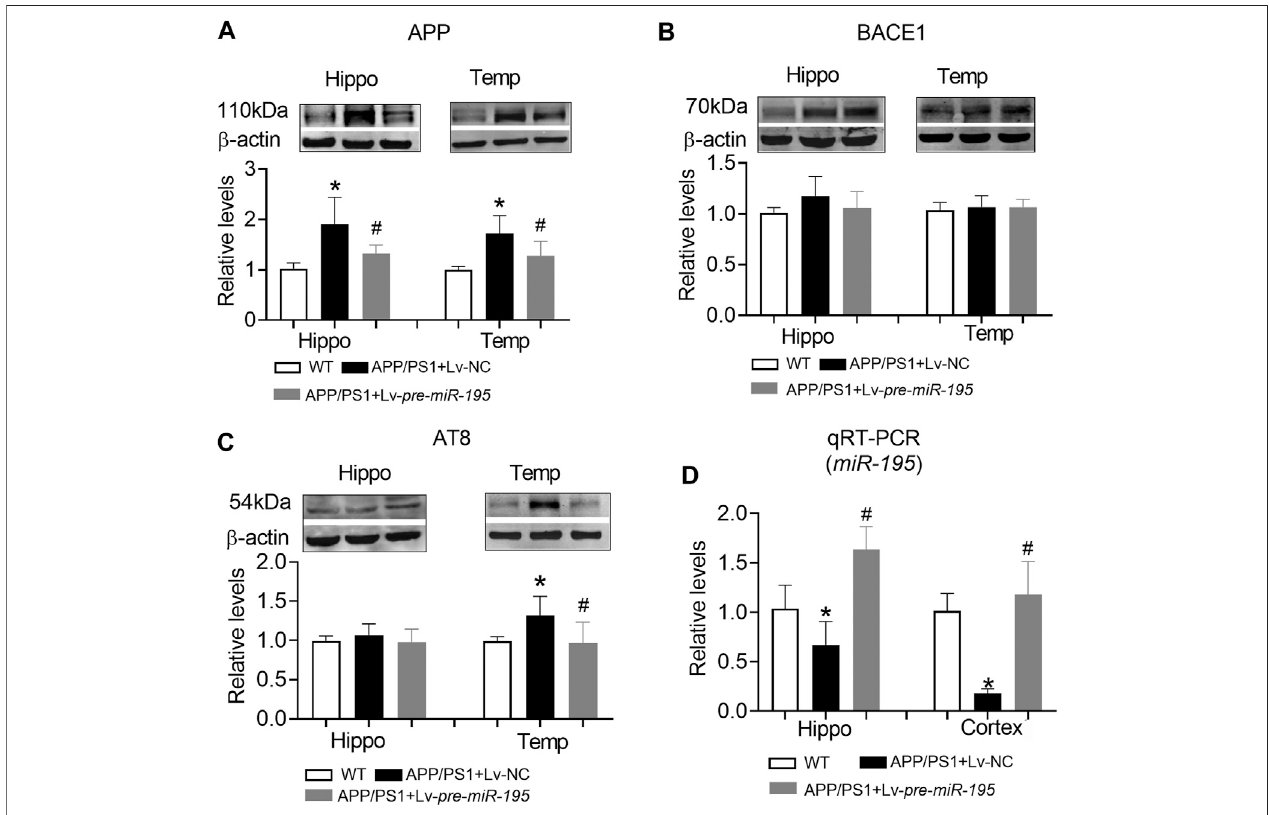
FIGURE 7 | The effect of miR-195 on the expression of APP, BACE-1, AT8 protein in the hippocampi of APP/PS1 mice after Lv-pre -miR-195 injection for 3M (A) MiR-195 down-regulated the expression of APP protein in the hippocampus and temporal lobe of APP/PS1 mice. * p < 0.05 vs. WT. # p < 0.05 vs. Lv-NC (B) There was no signi fi cant change in BACE-1 protein in hippocampus and temporal lobe of 7M-old APP/PS1 mice (C) MiR-195 reverses the high expression of AT8 in the temporal lobe of 7M-old APP/PS1 mice, but not in the hippocampus. * p < 0.05 vs. WT (D) MiR-195 levels in the hippocampus and cortex of APP/PS1 mice after brain injection of Lv-pre -miR-195 for 3M. * p < 0.05 vs. WT. # p < 0.05 vs. Lv-NC. n (cid:2)